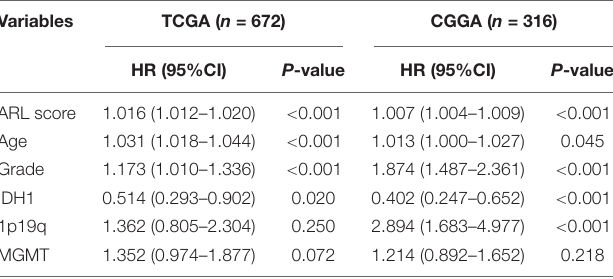
TABLE 2 | Multivariate analysis of ARL score in TCGA and CGGA datasets.